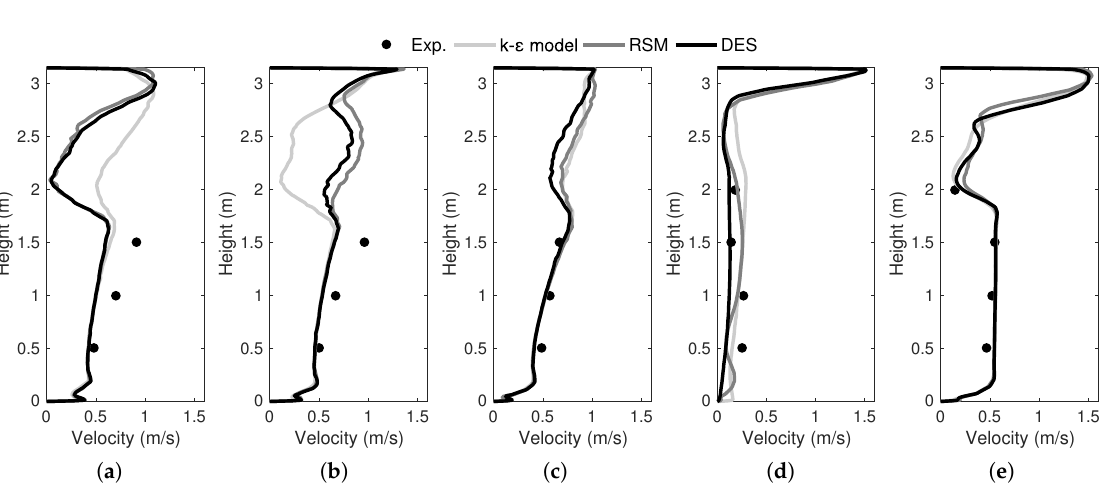
Figure 7. Velocity profiles at ( a ) L1; ( b ) L2; ( c ) L3; ( d ) L4; and ( e ) L5.